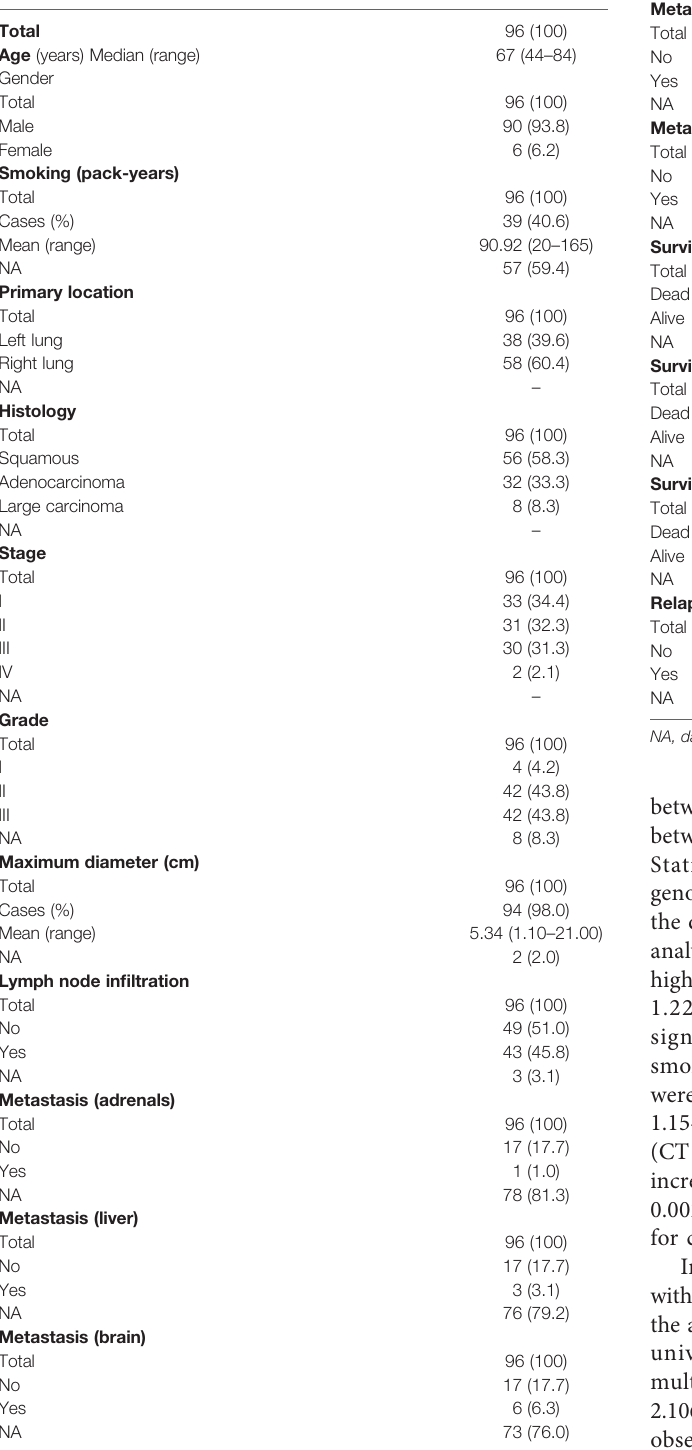
TABLE 4 | Clinicopathological characteristics and survival data of NSCLC patients studied by immunohistochemistry. Clinicopathological